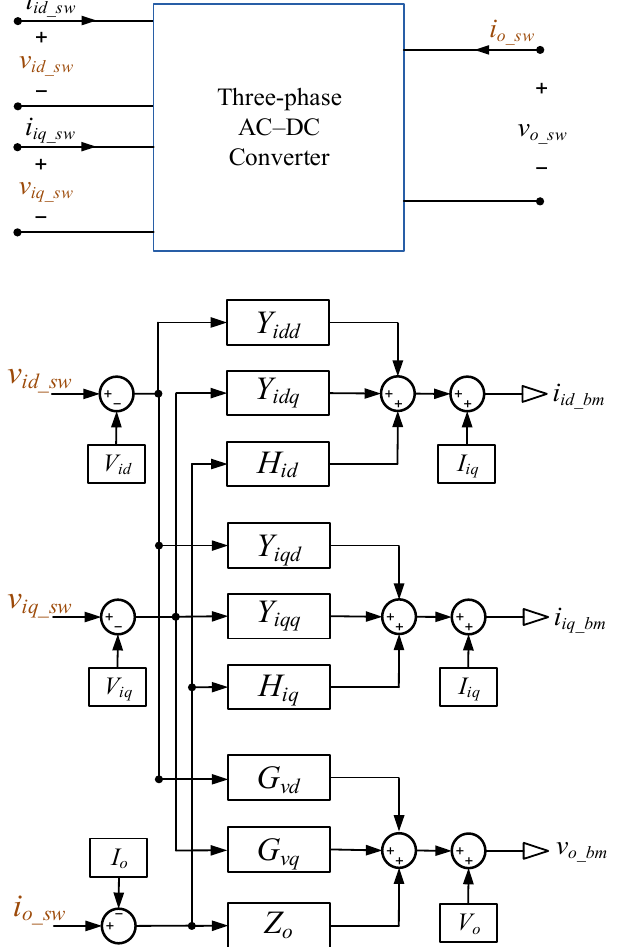
Figure 7. Behavioral model for the three-phase ac–dc converter.